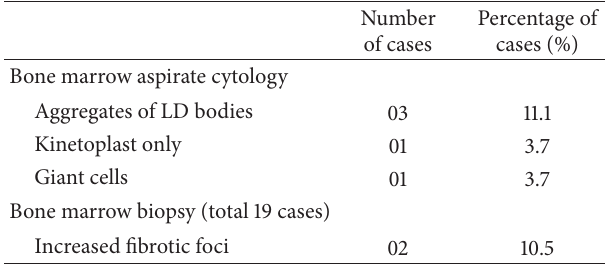
Table 4: Atypical bone marrow findings observed in leishmaniasis. Table 5: Comparison of hematological and bone marrow findings of the present study with previous studies in